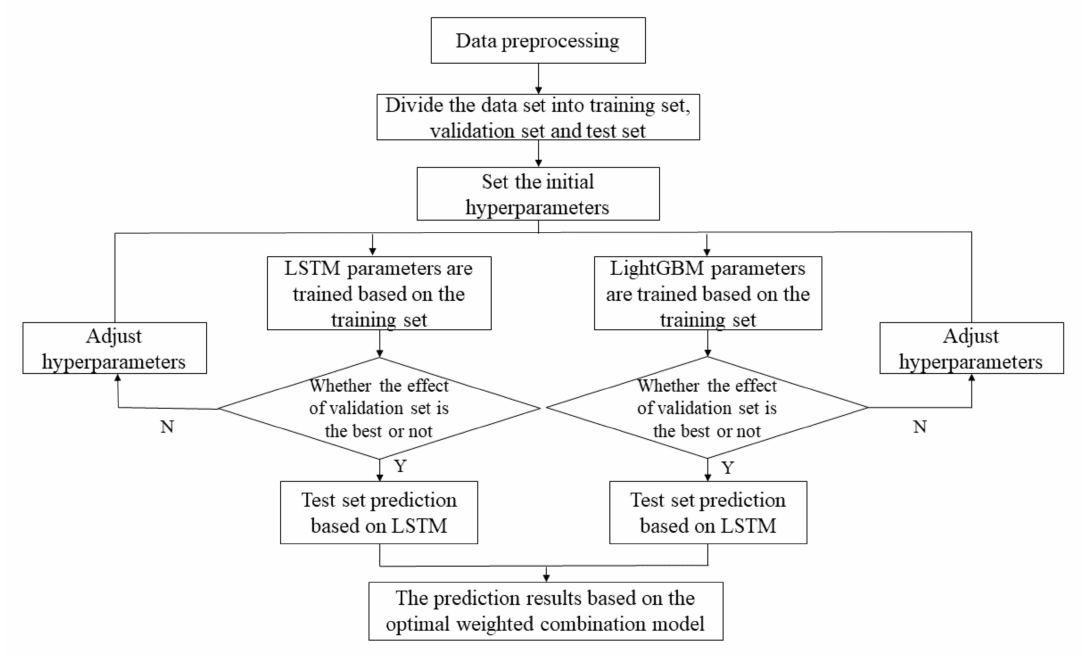
Figure 5. Flow chart of combined